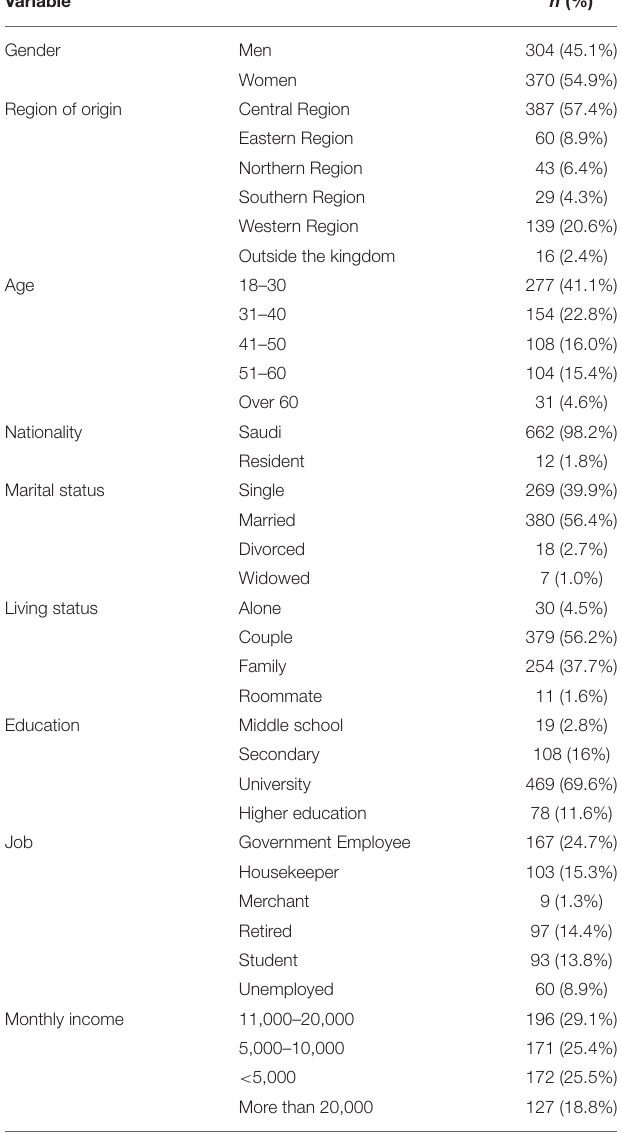
TABLE 1 | The distribution of participants by gender, age, region, marital and living status, education, income, and occupation.